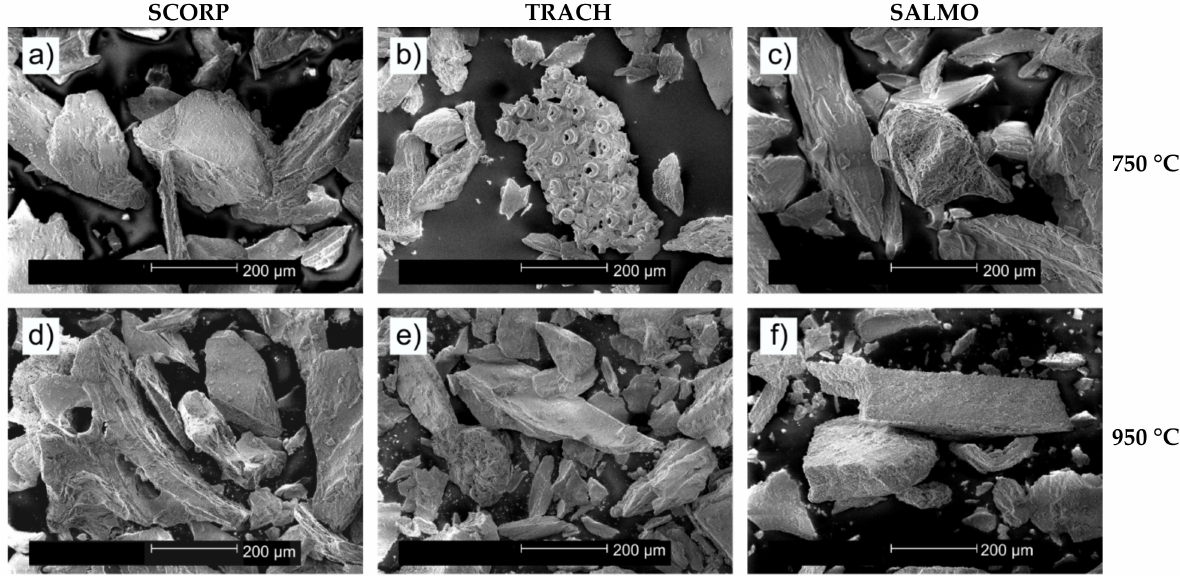
Figure 3. SEM micrographs of ( a ) Scorpaena scrofa , ( b ) Trachurus trachurus , and ( c ) Salmo salar bones calcined at 750 ◦ C, as well as ( d ) Scorpaena scrofa , ( e ) Trachurus trachurus , and ( f ) Salmo salar bones calcined at 950 ◦